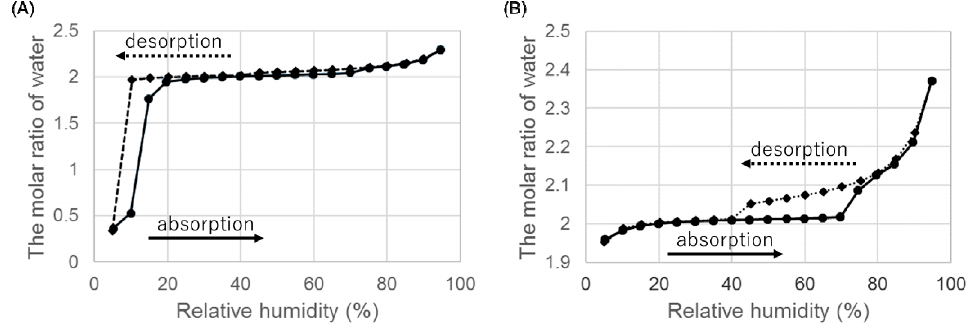
Figure 6. Hygroscopicity of ondansetron salts dihydrate at 25 °C. ( A ) Hydrobromide dihydrate and ( B ) hydroiodide dihydrate.